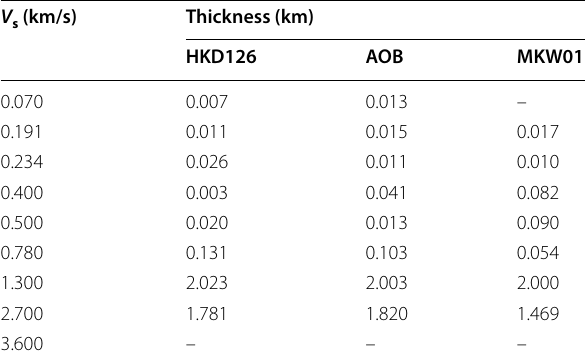
Table 3 Estimated S‑wave velocities and layer thickness at three sites